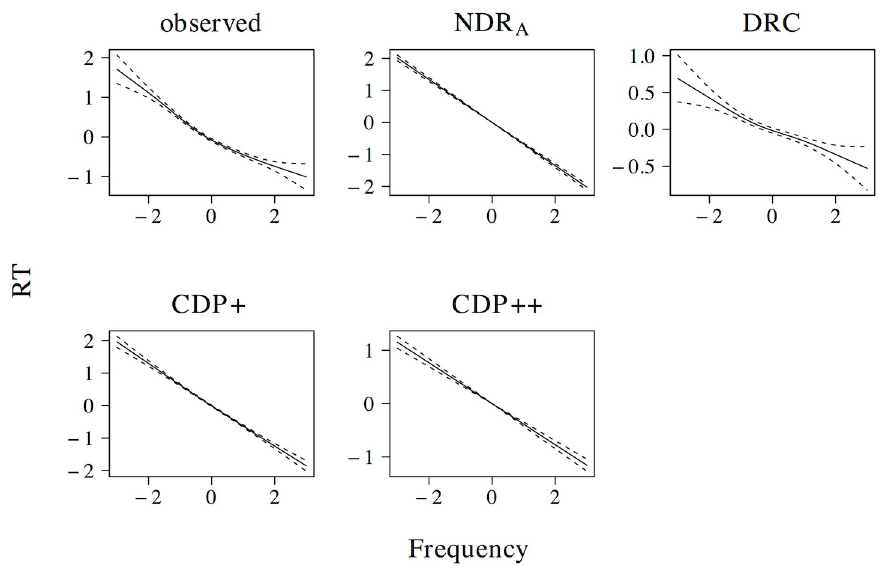
Fig 16. Frequency. The effect of frequency in word naming.